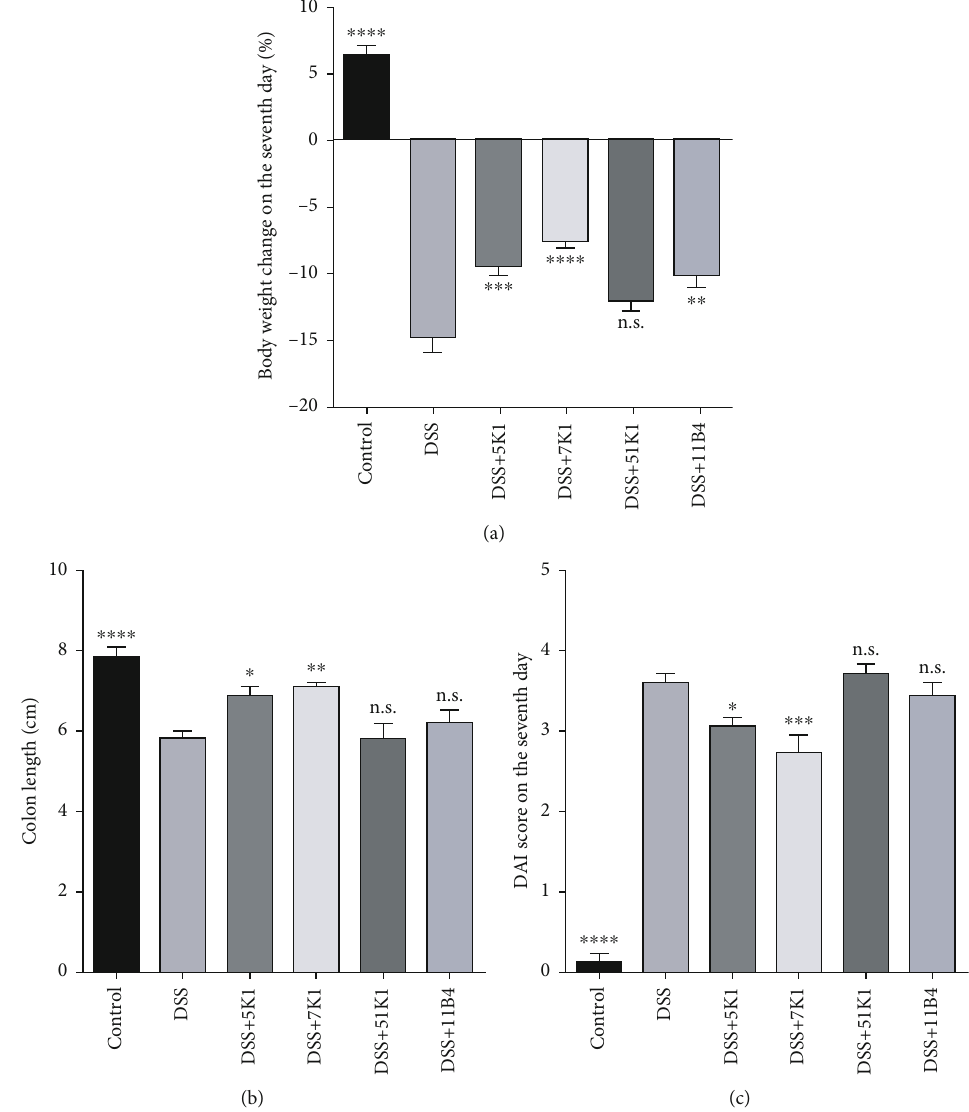
Figure 2: E ff ect of Bacteroides vulgatus on colitis symptoms. (a) Body weight. (b) Colon length. (c) Disease activity index (DAI). Six mice per